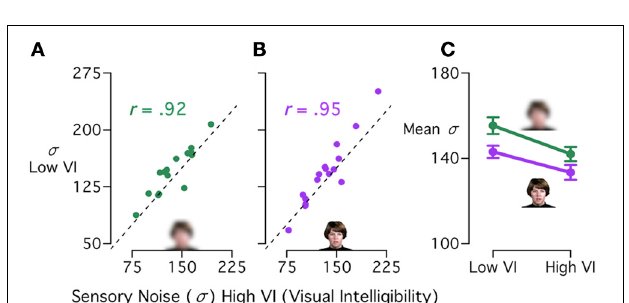
FIGURE 5 | Model comparison across experiments. (A) Total fit error (Bayesian Information Criterion; BIC) across conditions averaged over the 16 subjects in experiment 1 showing better fit for the CIMS model ( ∗∗ p < 0 . 001). Error bars are within-subject standard error (Loftus and Masson, 1994). (B) Difference in fit error (BIC) for each individual subject (across all conditions). (C) Total fit error across conditions averaged over the 21 subjects in experiment 2 showing better fit for the CIMS model ( ∗∗ p < 10 − 15 ). (D) Difference in fit error for each individual subject (across all conditions).